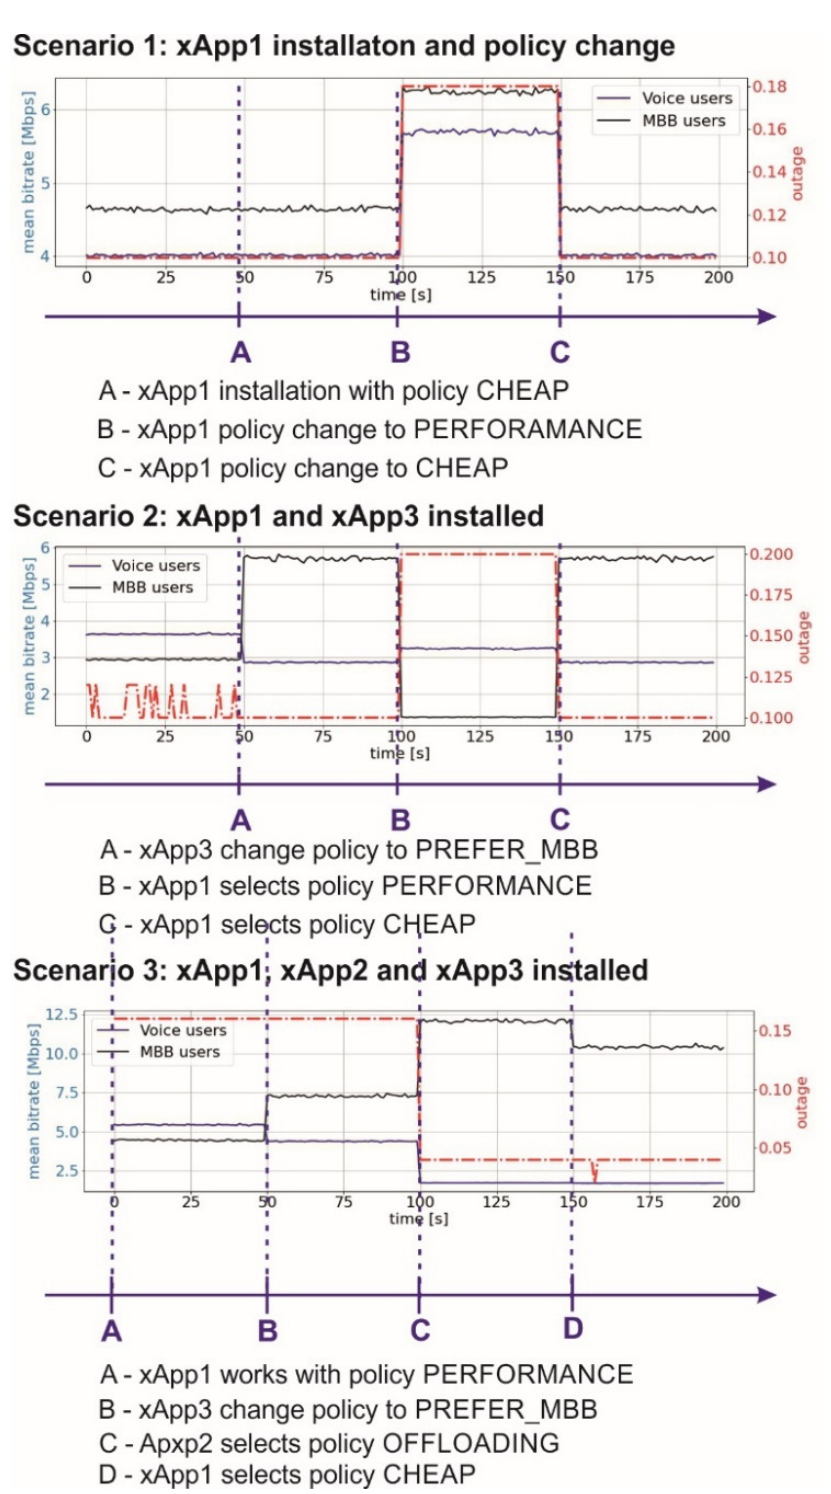
Figure 4. Achieved results for three considered experimentation schemes.